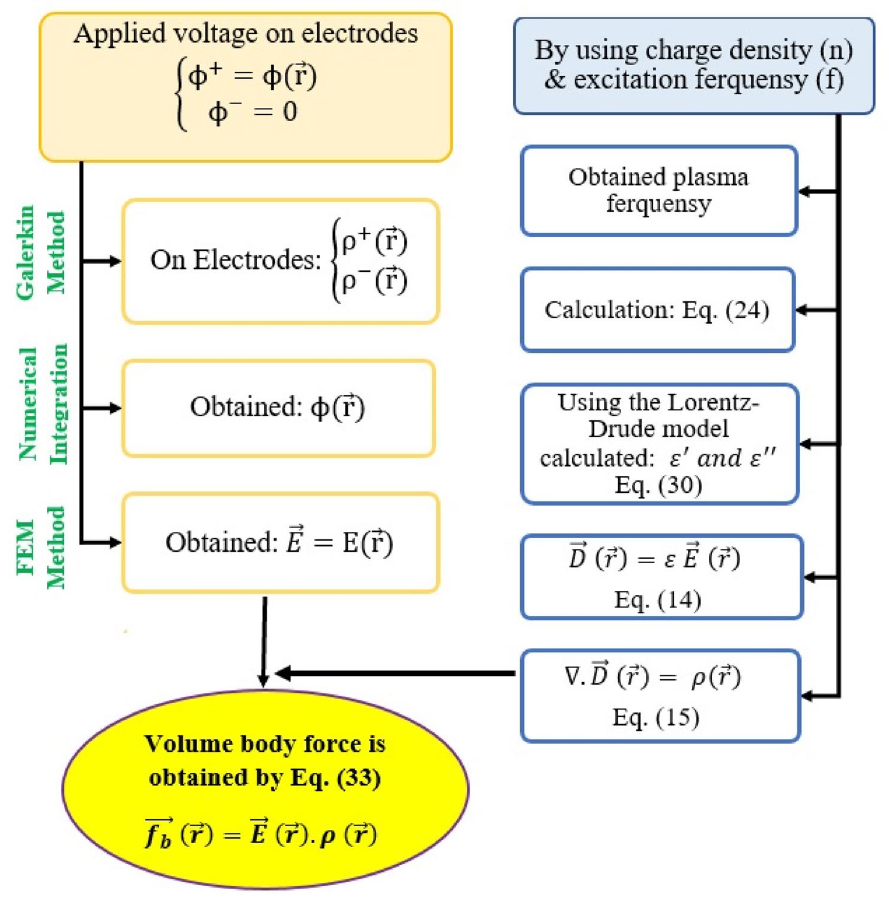
Figure 2. The schematic calculation procedure of the New Lorentz Force (Volumetric Body Force) mathematical procedure with the associated Numerical procedure for each